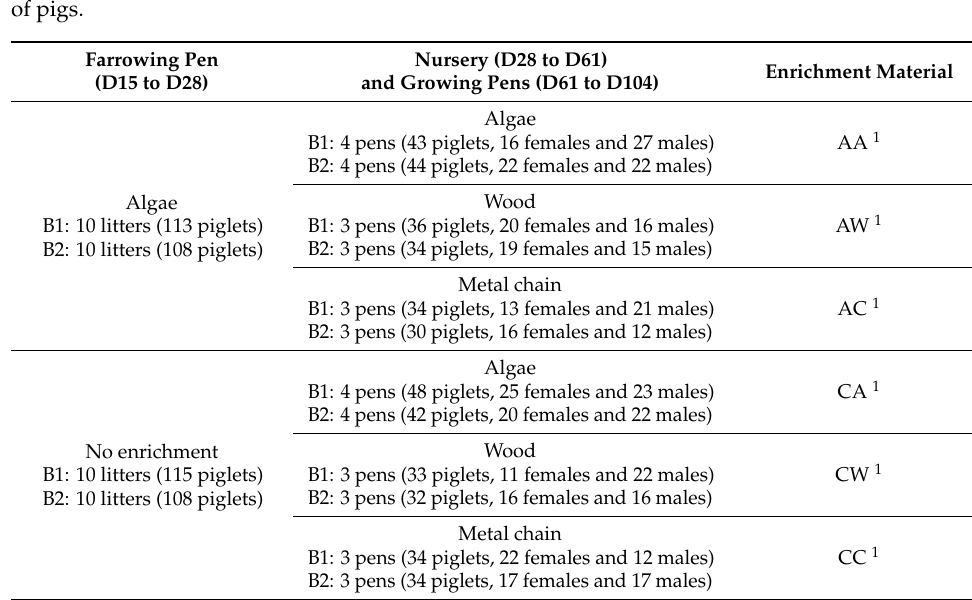
Table 1. Experimental design and types of enrichment. Pigs from one litter remained together in the same group and in the same pen during the whole study period. D: day of experiment; B: